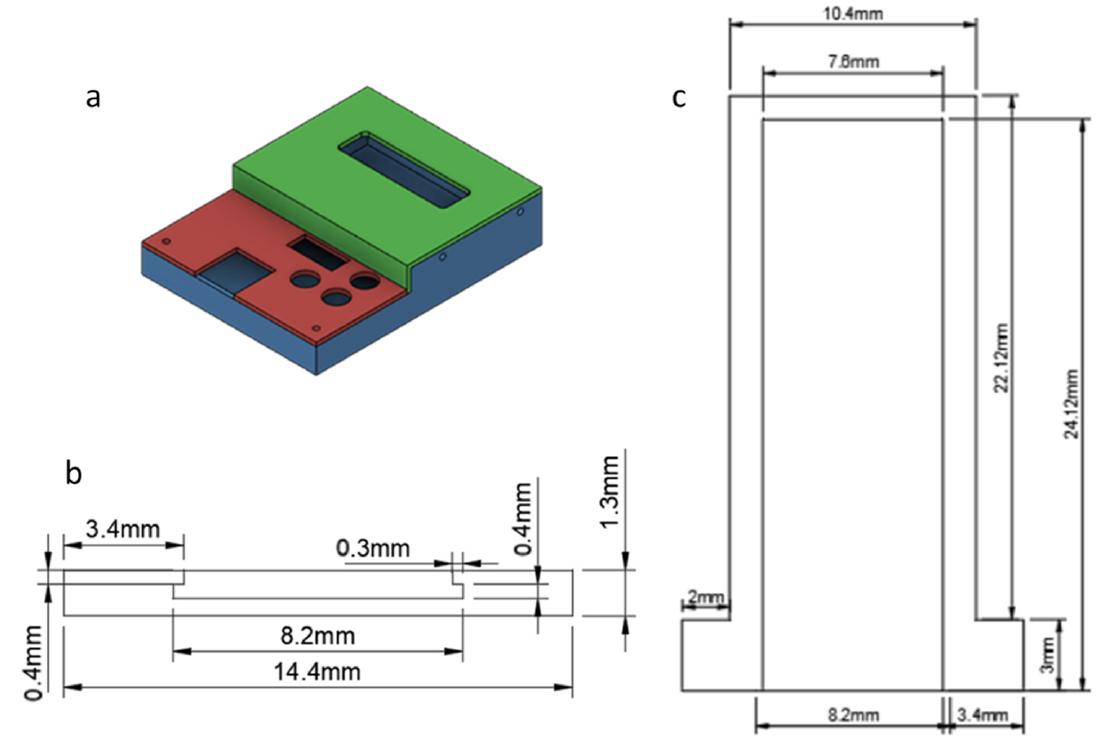
Figure 3. Readout circuit packaging design: ( a ) schematic; base (blue); bottom lid (red); top lid (green); ( b ) front view; and ( c ) top view.